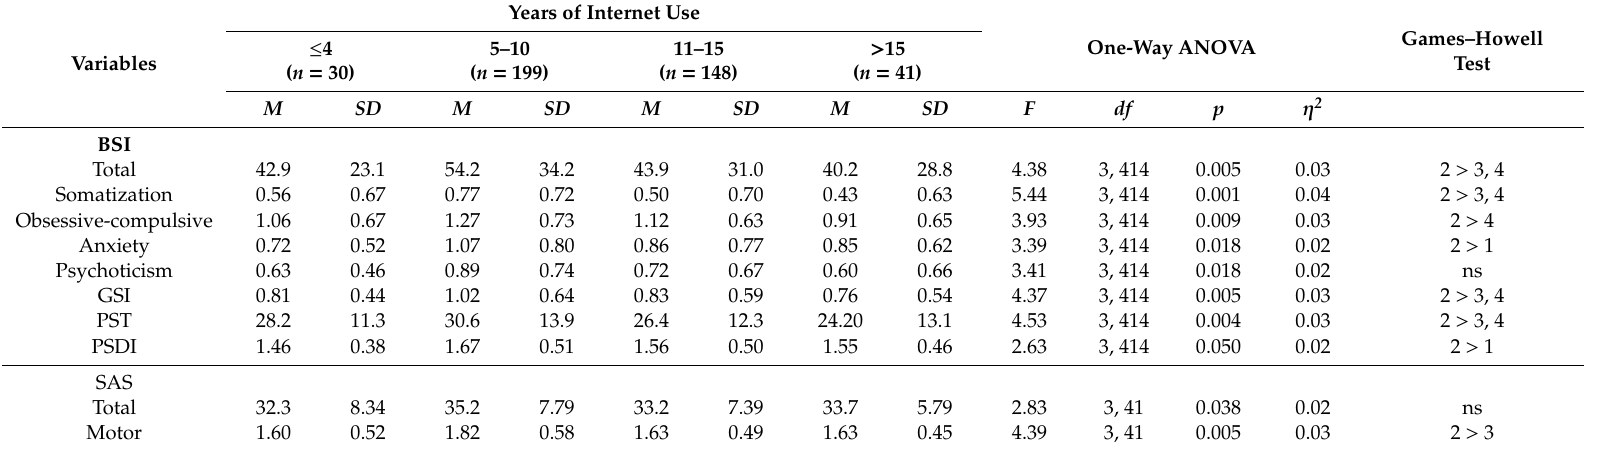
Table 12. Significant means di ff erences of dependent variables in relation to years of Internet